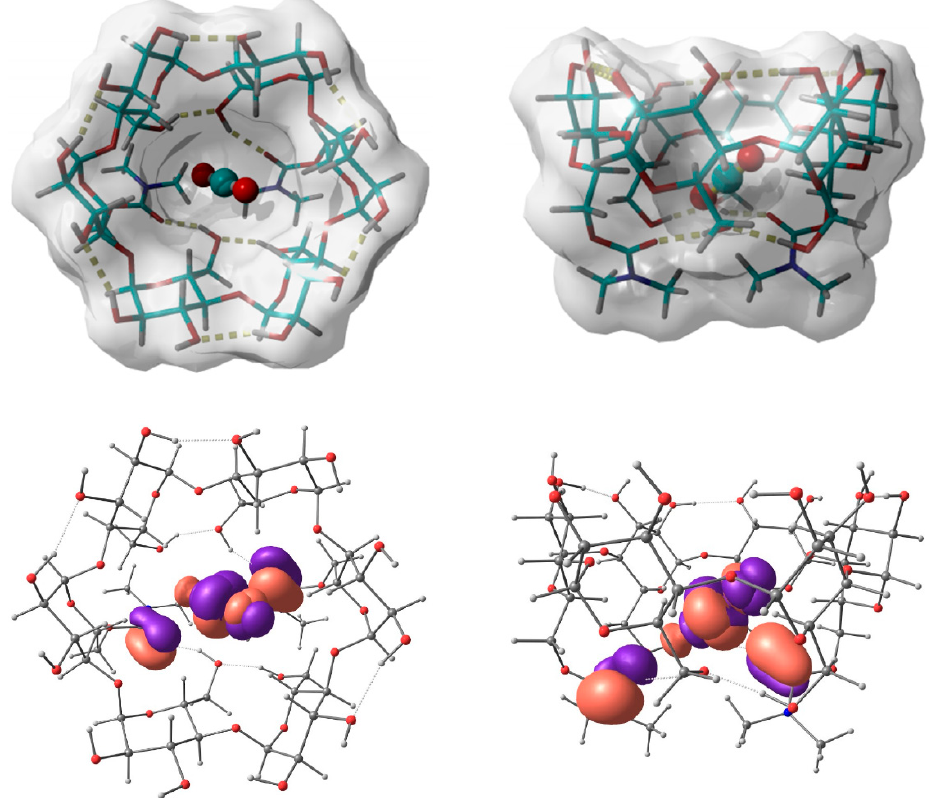
Figure 6. The 3D optimized molecular structure of the dicarbamoyl functionalized α -CD with one CO 2 molecule within the cavity. Top: front (left) and side (right) views with the molecular surface. Bottom: front (left) and side (right) views with the molecular orbital interactions.